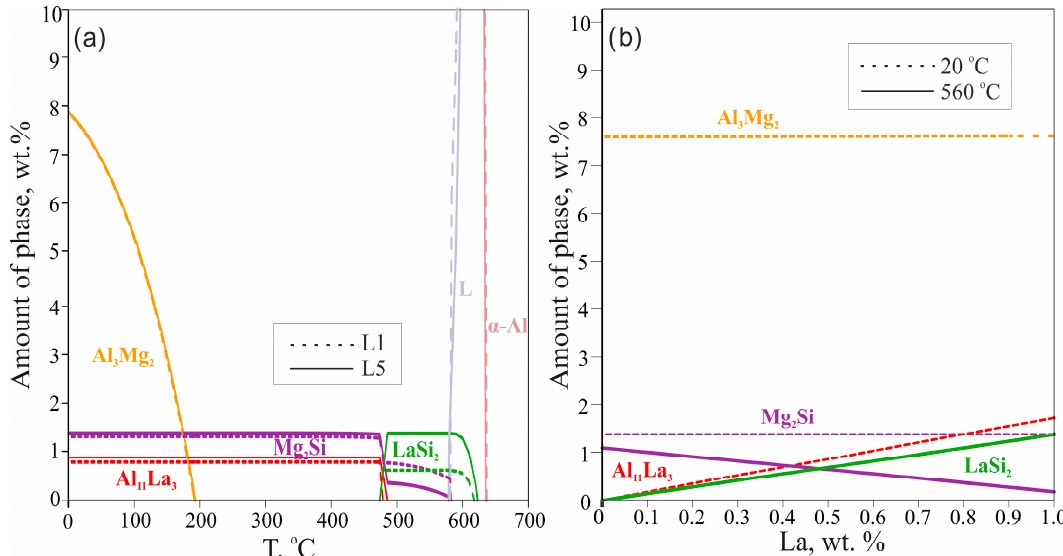
Figure 2. Calculated phase fractions for L1 and L5 alloys as a function of temperature ( a ); calculated phase fractions in Al—4 wt.% Mg—0.5 wt.% Si alloy for 20 °C and 560 °C as a function of La content ( b ) .